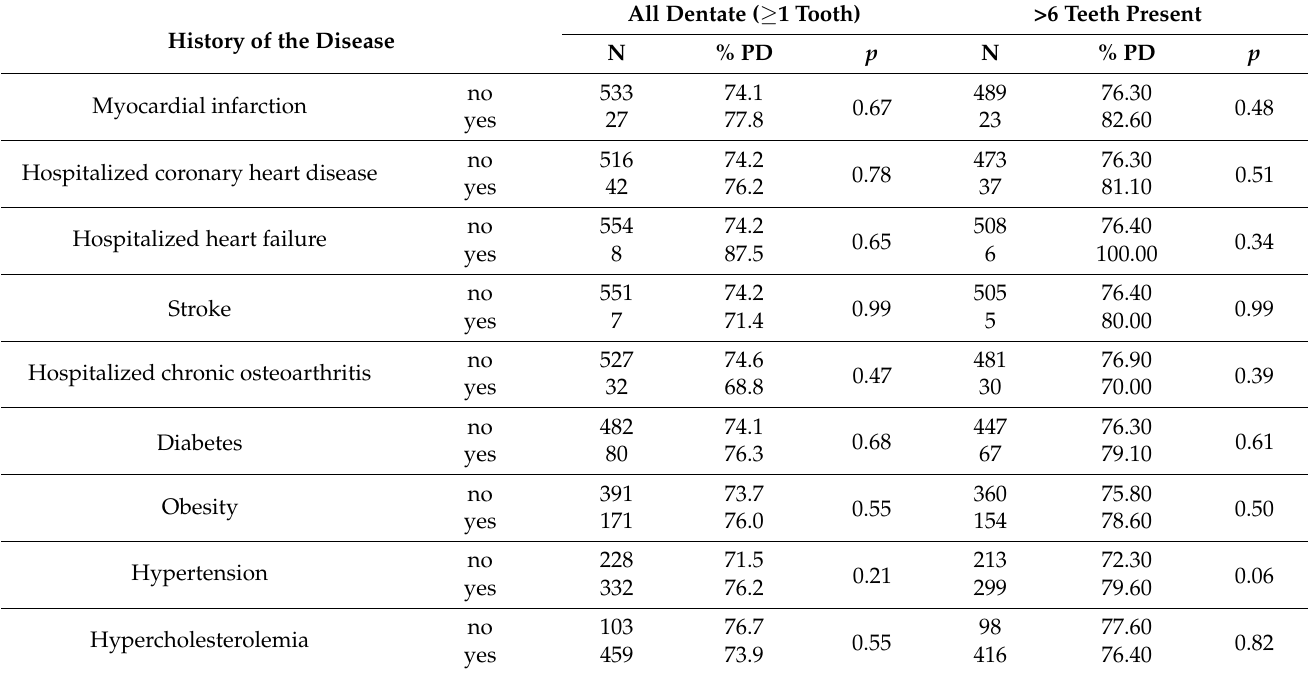
Table 3. Percentage of participants with periodontitis (% PD) by history of chronic diseases in all dentate persons and persons with ≥ 6 teeth